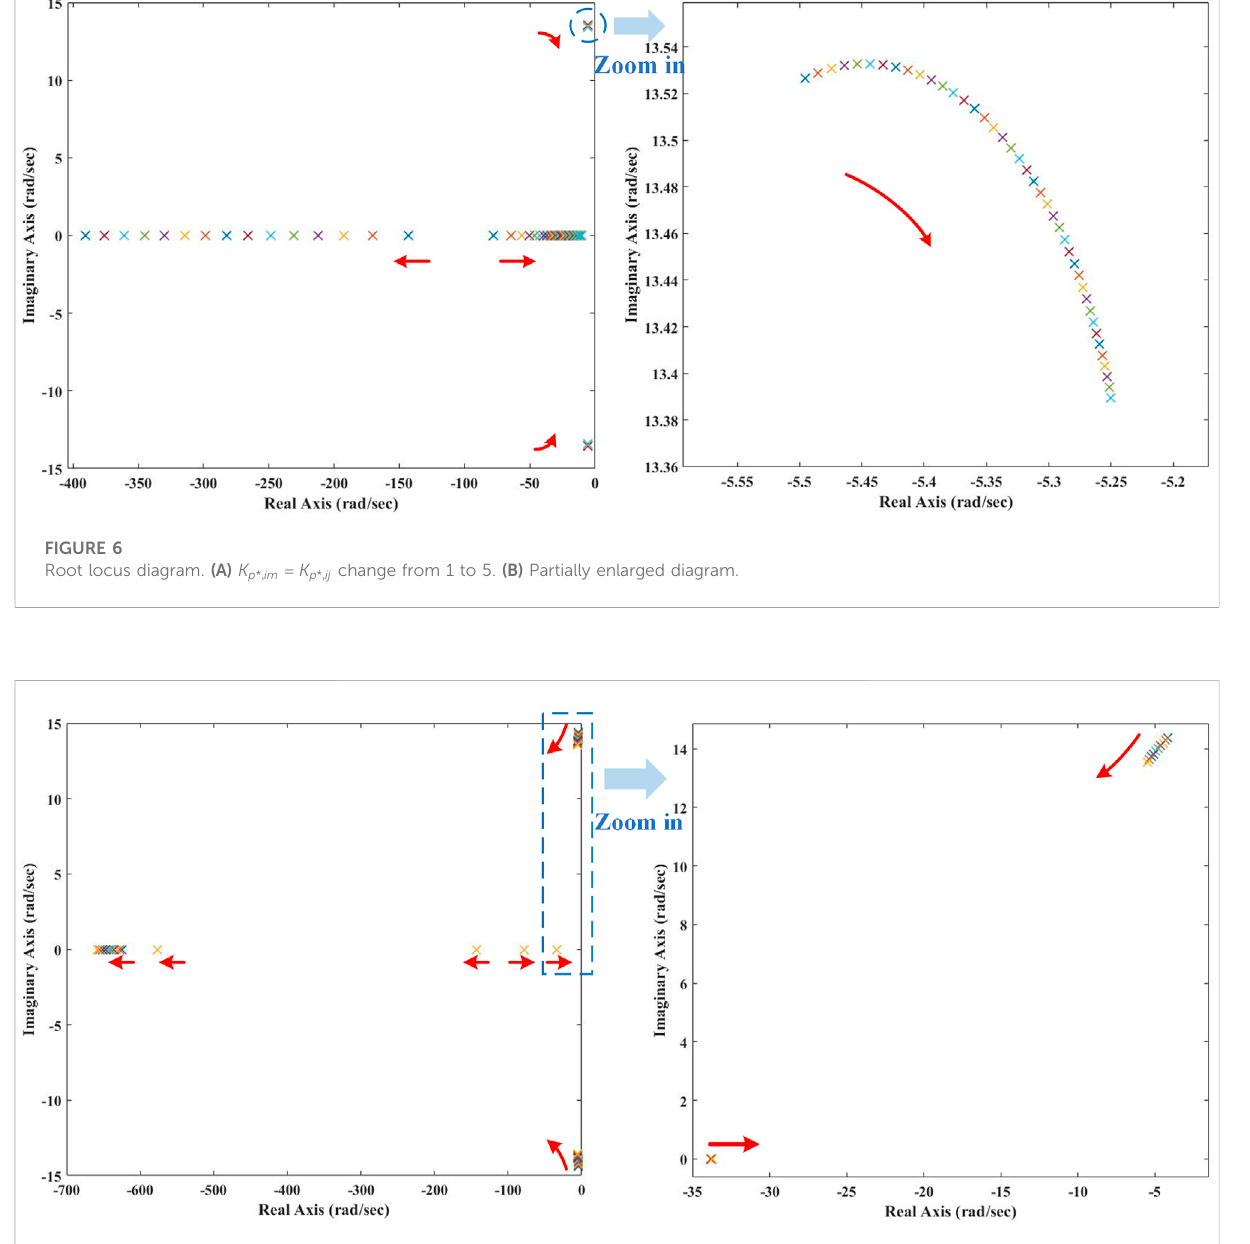
FIGURE 7 Root locus diagram. (A) K vp * , ij change from 0.01 to 0.1. (B) Partially enlarged